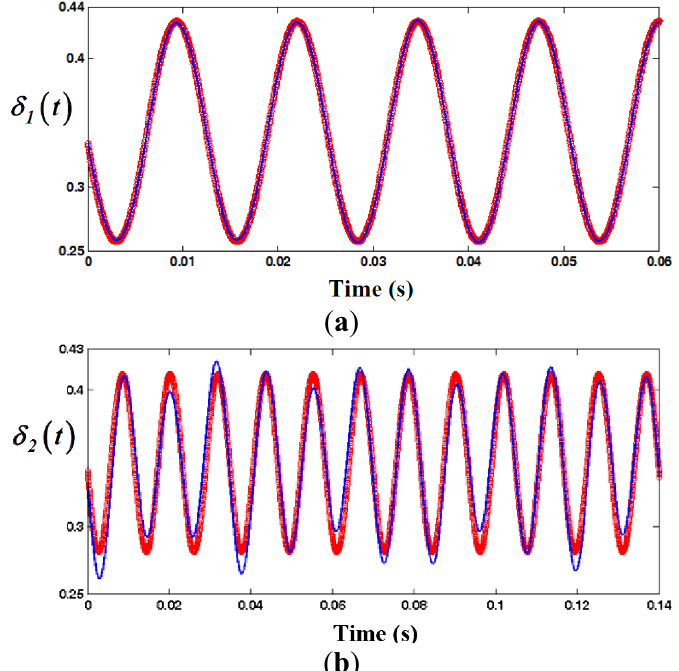
Figure 11. Comparison of results from HBM ( N max = 12 and ρ = 1) and NS at the unstable t  from HBM results; and ( b ) comparison of regime: ( a ) max, mean, and min values of   1 HBM and NS under the unstable regime. Key: ━━ , HBM;  , HBM with stable regime (or NS by frequency up-sweeping);  , HBM with unstable regime (or NS by frequency down-sweeping).